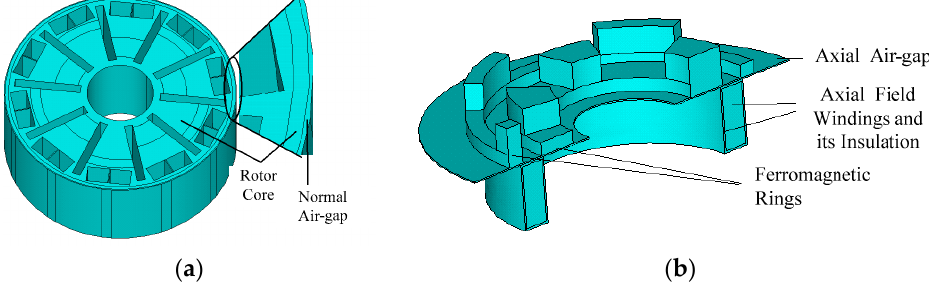
Figure 6. Schematic diagram of air-gap of the machine, ( a ) normal air-gap; and, ( b ) axial air-gap.